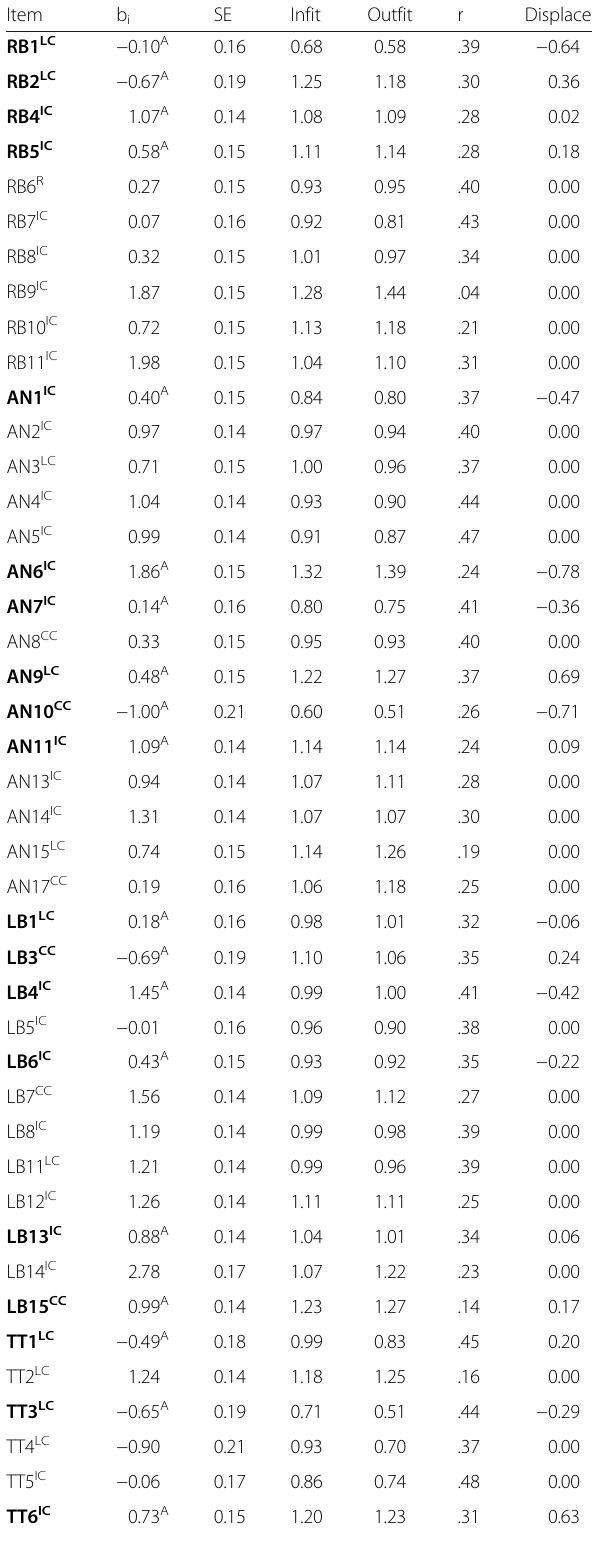
Table 4 Psychometric properties of the items of the TRC-n-4